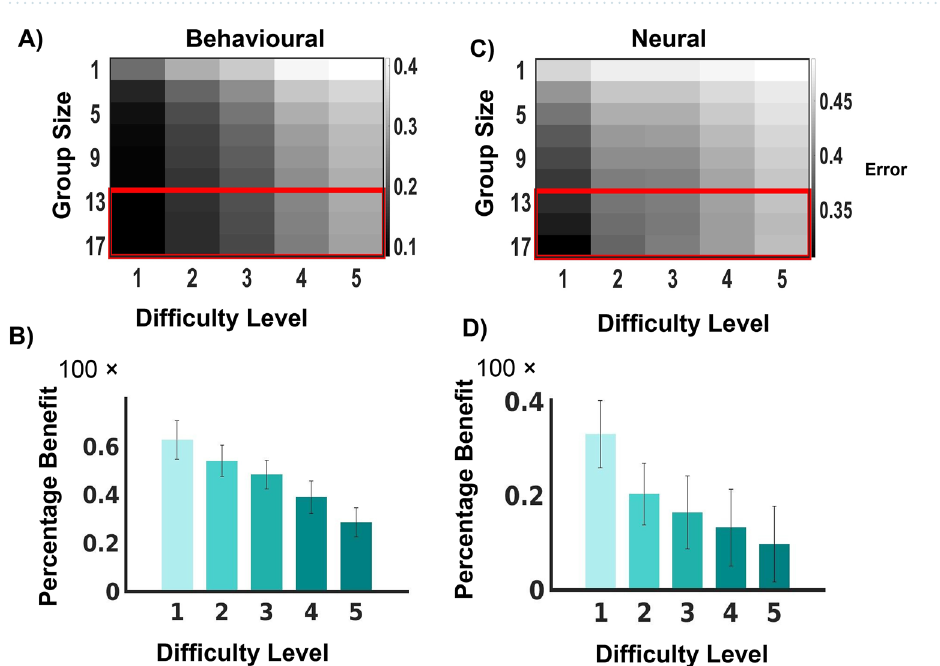
Figure 5. Group Aggregation and Task Difficulty. ( A ) and ( C ) depict the classification error rate across group sizes and difficulty levels for behavioural and neural data. Classification error rate increases with increasing task difficulty. This error is significantly reduced upon combining the individual decisions using the group aggregation rule. The colour bars indicate the magnitude of classification error rate. ( B ) and ( D ) show percentages of the benefit of group decision making (maximum group size vs individual) as a function of difficulty level for behavioural and neural data, respectively. Benefits reduce with increasing difficulty. Error bars represent ±